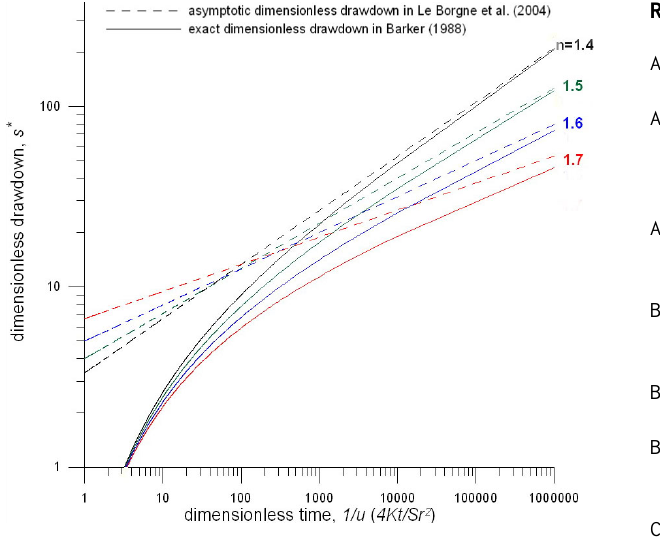
Fig. 9. Dimensionless drawdown versus dimensionless time for flow dimension n varying from 1.4 to